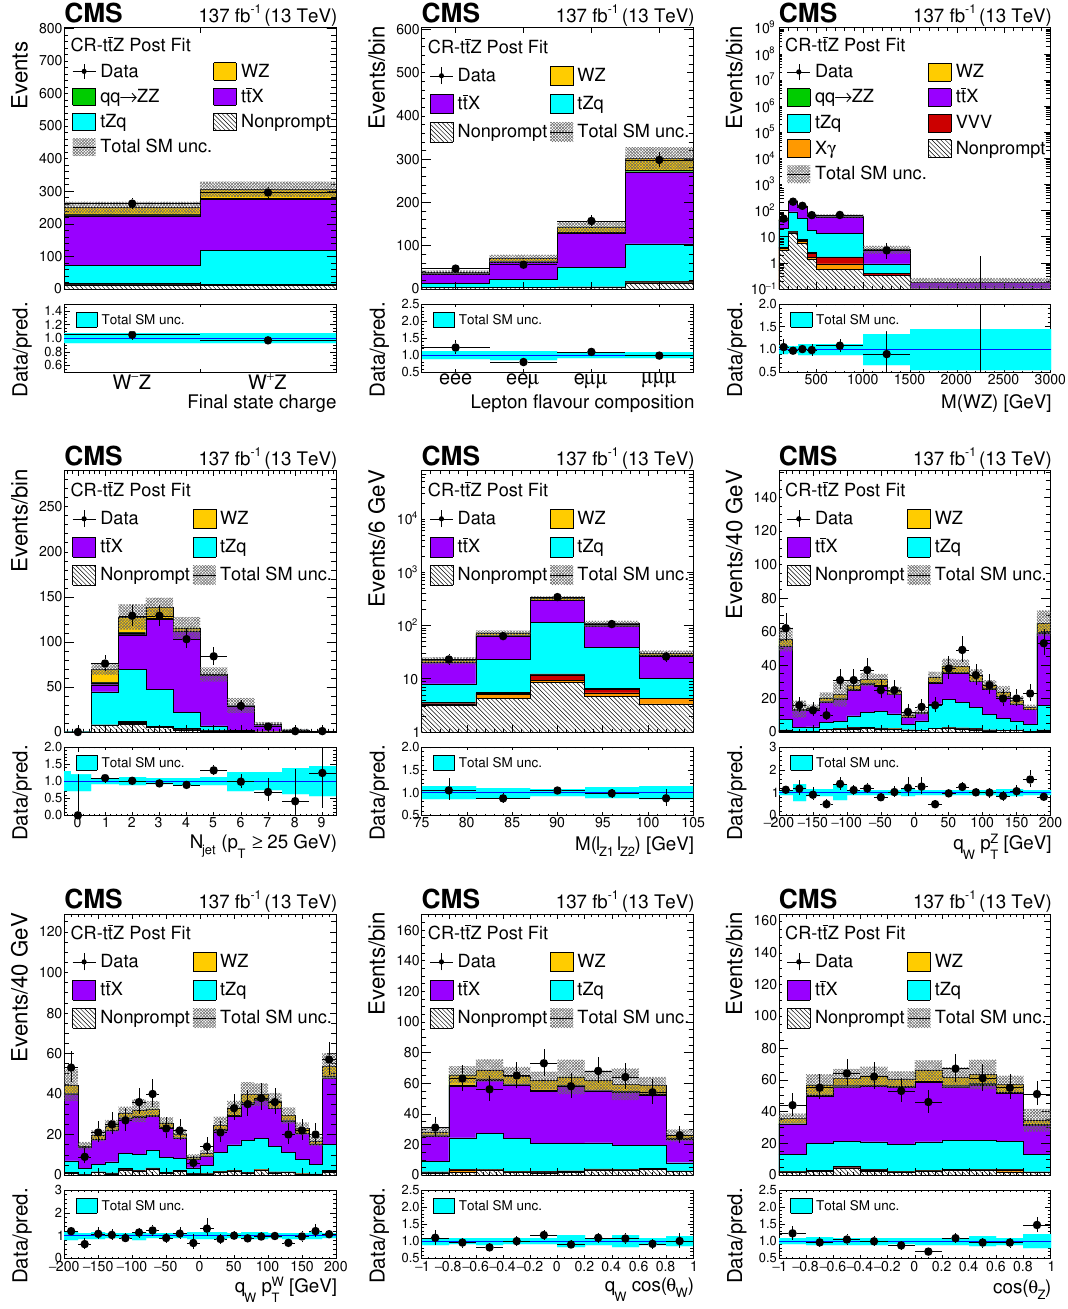
Figure 3 . As in figure 2, for the distribution of observables in the ttZ control